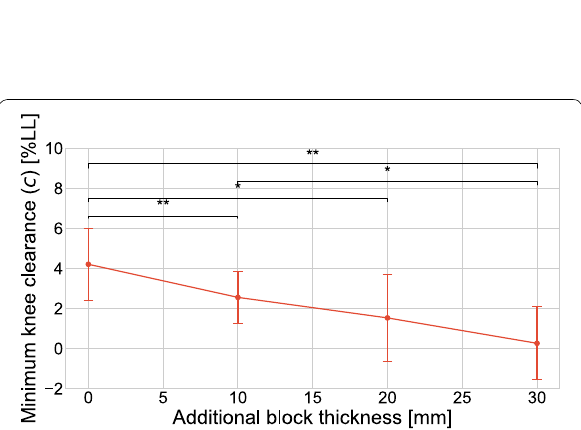
Fig. 9 Additional block thickness and minimum knee